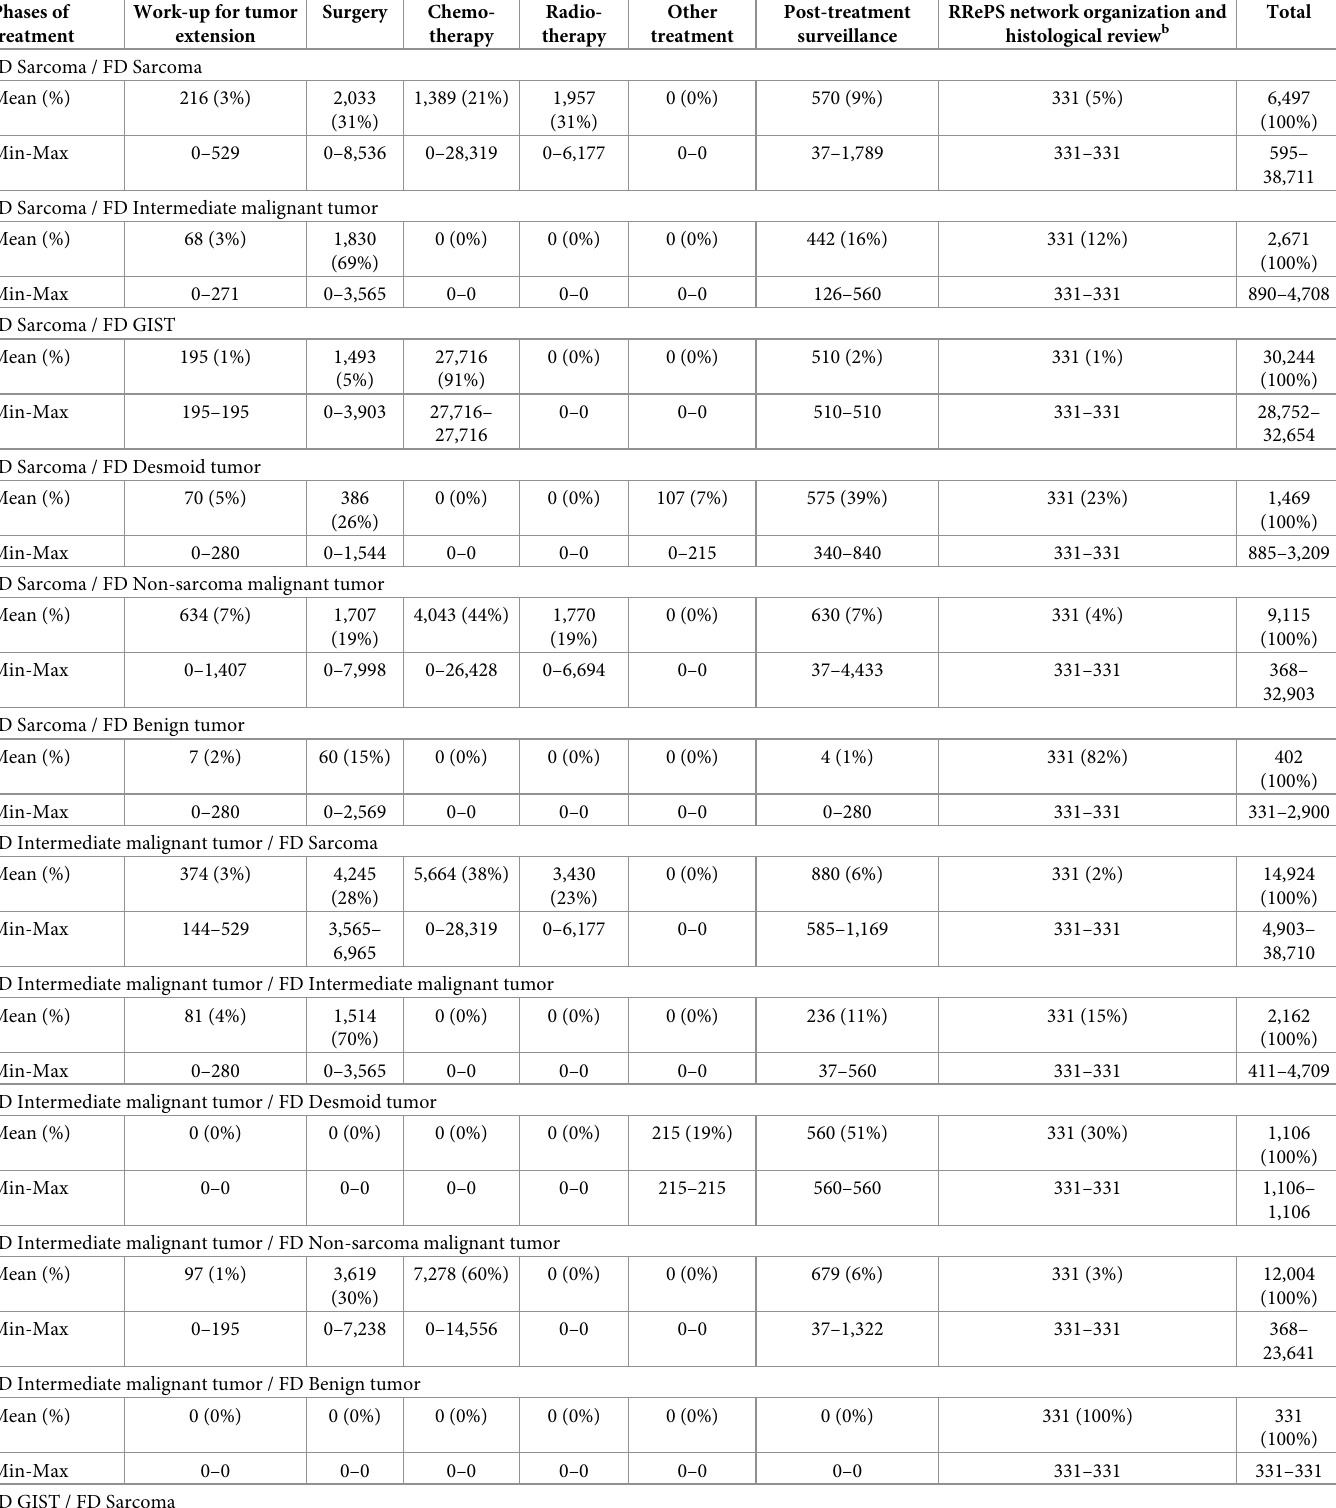
Table 7. Costs of disease managements (in € for 2013) a